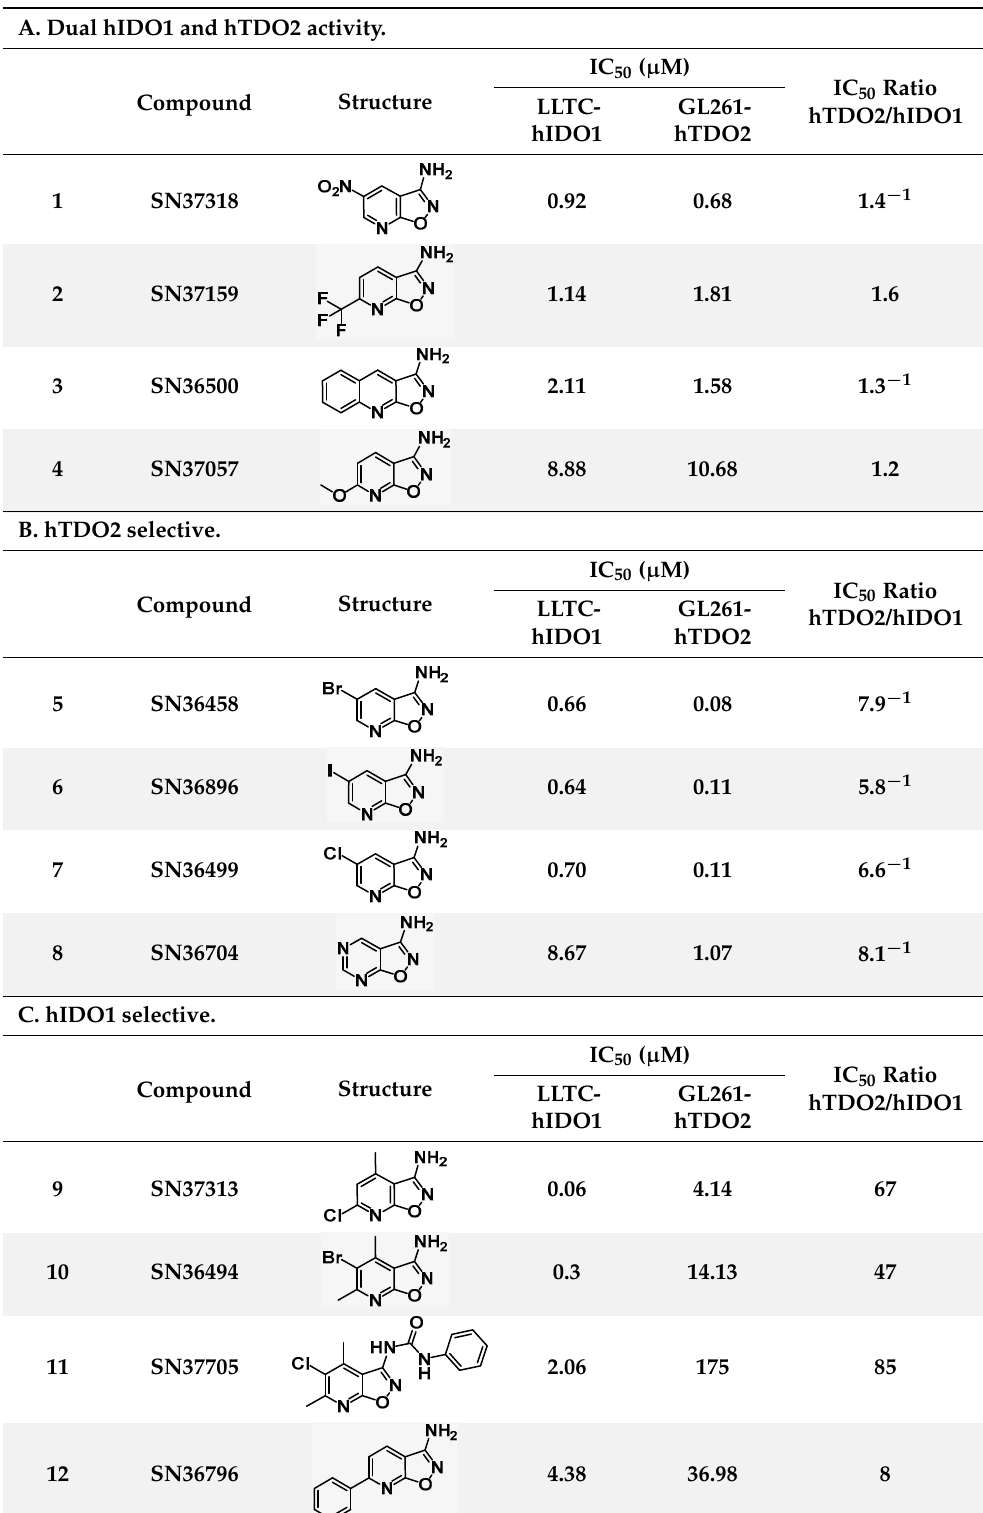
Table 2 . IC 50 values for inhibition in cell-based assays against LLTC-hIDO1 and GL261-hTDO2 of ( A ) dual IDO1/TDO2 inhibitors ( B ) hTDO2-selective and ( C ) hIDO1-selective analogues compared with ( D ) reference controls W-0019482 and INCB14934.